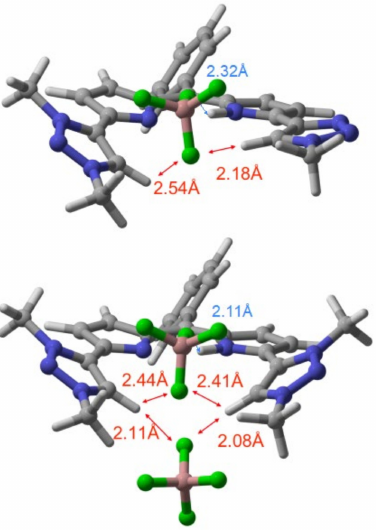
Figure 4. HETCOR 1 H- 19 F NMR experiment of DPMT-1 highlighting the “covalent-like” bond between the triazole protons of DPMT-1 and the counter anion BF 4 − .